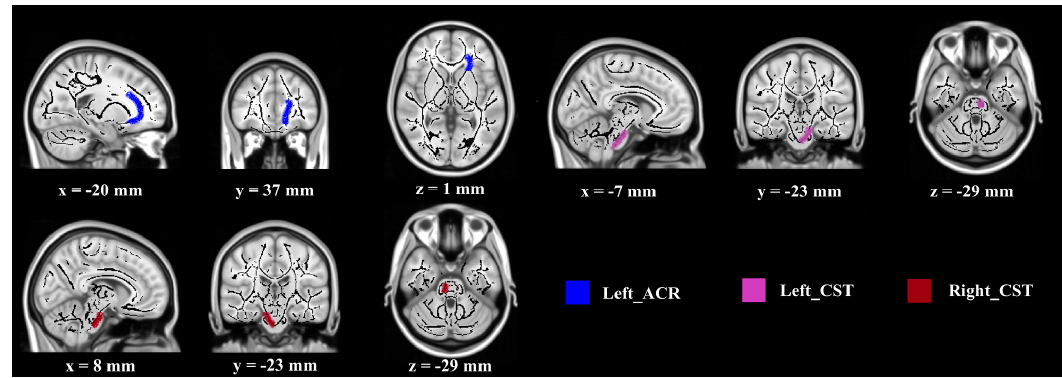
Figure 2. Demonstration of brain regions with significant MD increases after intervention. (Notes—Lower MD value indicates better SC function. Regions are overlaid on